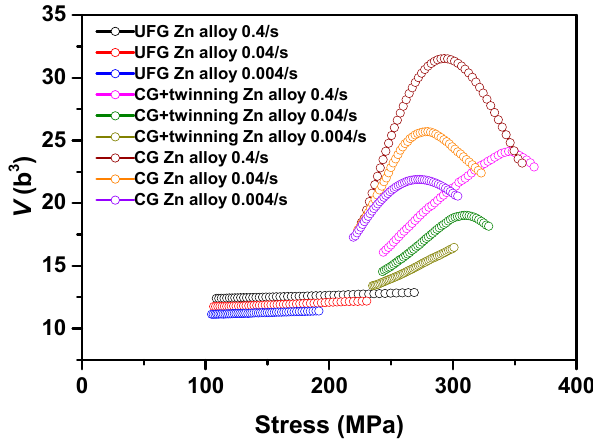
σ − σ V − H curves of UFG curves of UFG/CG+twinning/CG Zn alloys during holding time. Figure 8. V H